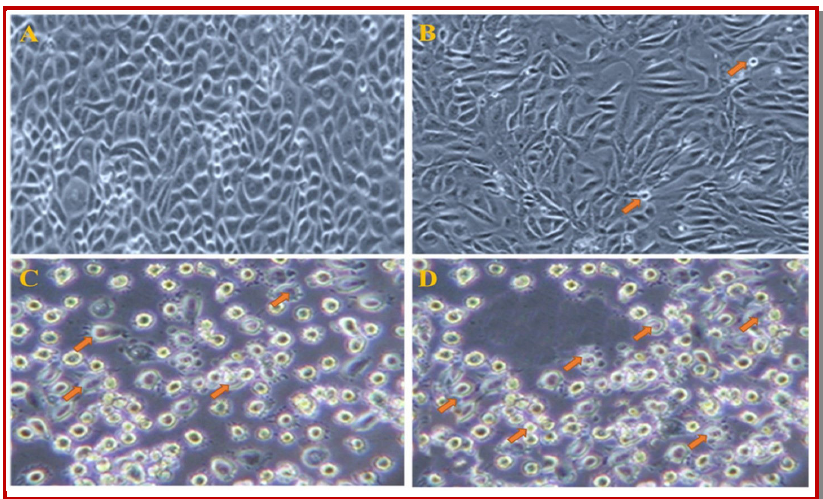
Figure 2: Morphology changes of A-549 cells after theaflavin-3-gallate treatment for 48 hours. Compound treated cells were rounded and there was no cell to cell adhesion. Arrows show membrane blebbing and rounded cells at 40x magnification. A, shows control cells with excellent cell to cell adhesion and normal cellular morphology. B, C and D represent cells treated with 20, 80 and 160 µM dose of